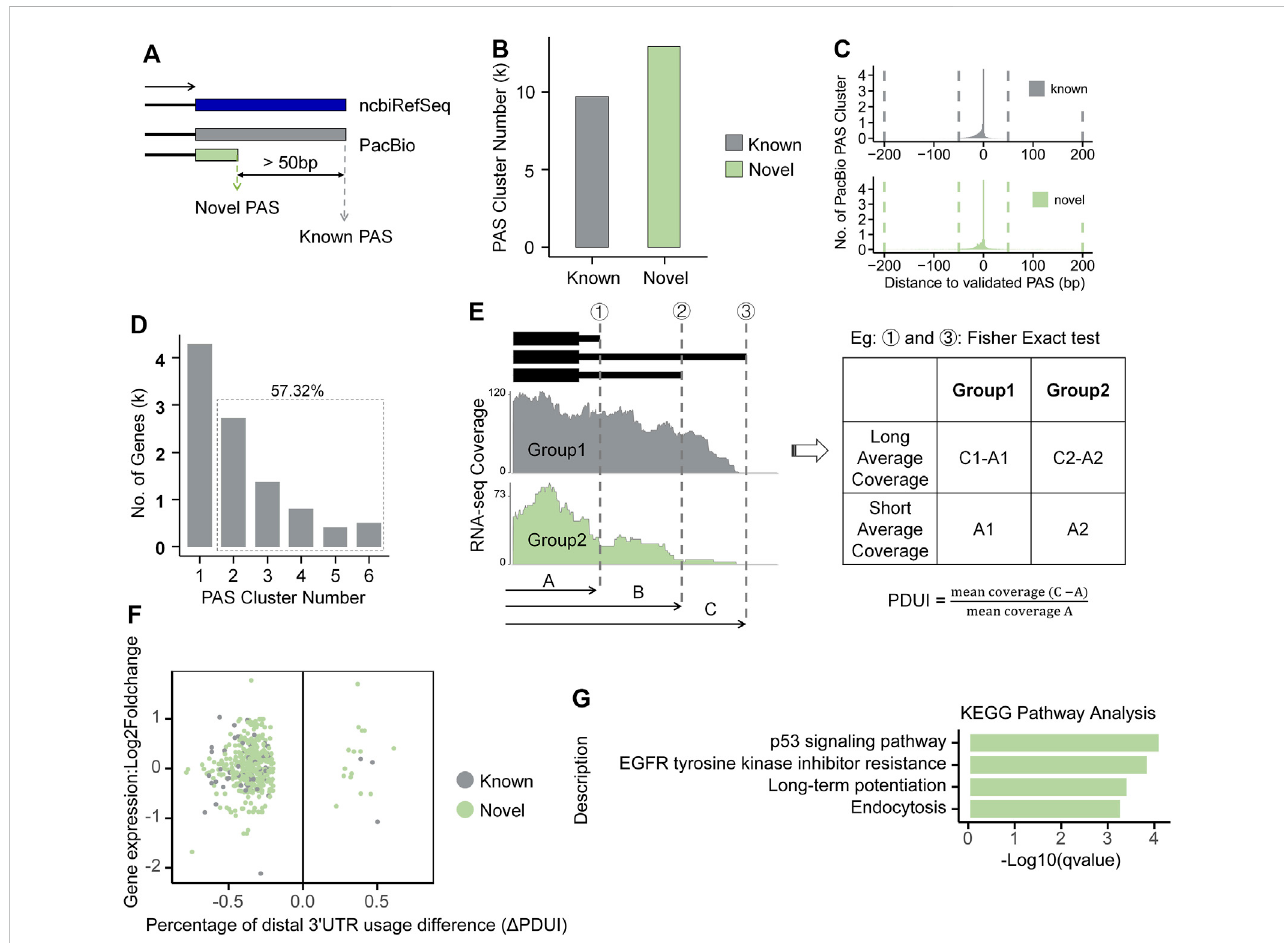
FIGURE 5 Global analysis of alternative polyadenylation combined with Iso-Seq and RNA-seq in RAECs. (A) The Schematic diagram of known and novel PASs. (B) ThenumberofknownandnovelPASsidenti fi edbyIso-Seq. (C) HistogramofthegenomicdistancebetweenIso-Seqidenti fi edPASsandvalidated3 ′ endspool inbothknownandnovelclasses. (D) DistributionofgenesthathaveoneormorePAS. (E) DifferentialusageofPASwascalculatedbasedongivenproximalPAS as prior knowledge. (F) Scatter plot between Δ PDUI and expression changes for genes with signi fi cantly longer or shorter 3 ′ UTRs. Green and gray represent genes with novel and known PASs, respectively. (G) KEGG pathway enrichment analysis for genes tended to use proximal PAS after Ang II